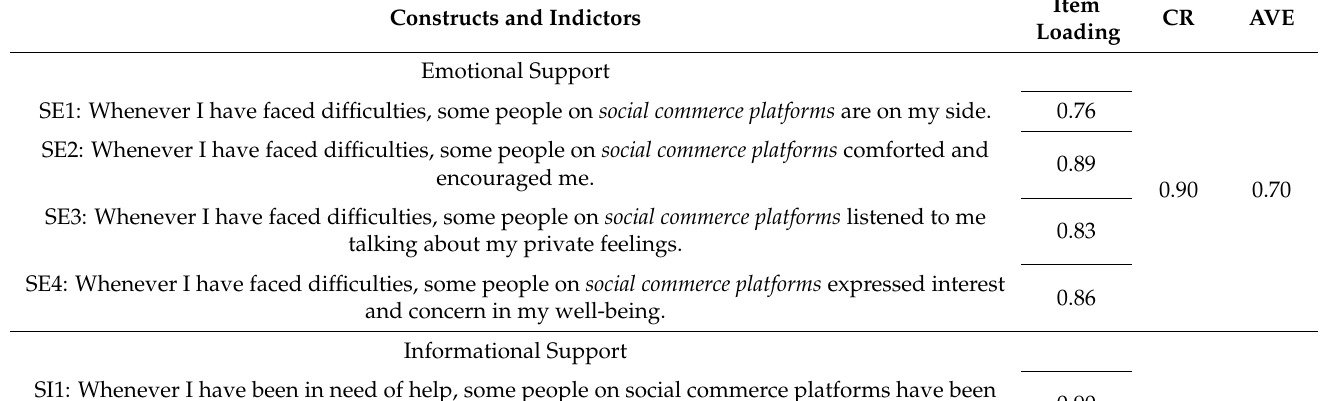
Table 2. Measurement items loading, CR, and AVE. Constructs and